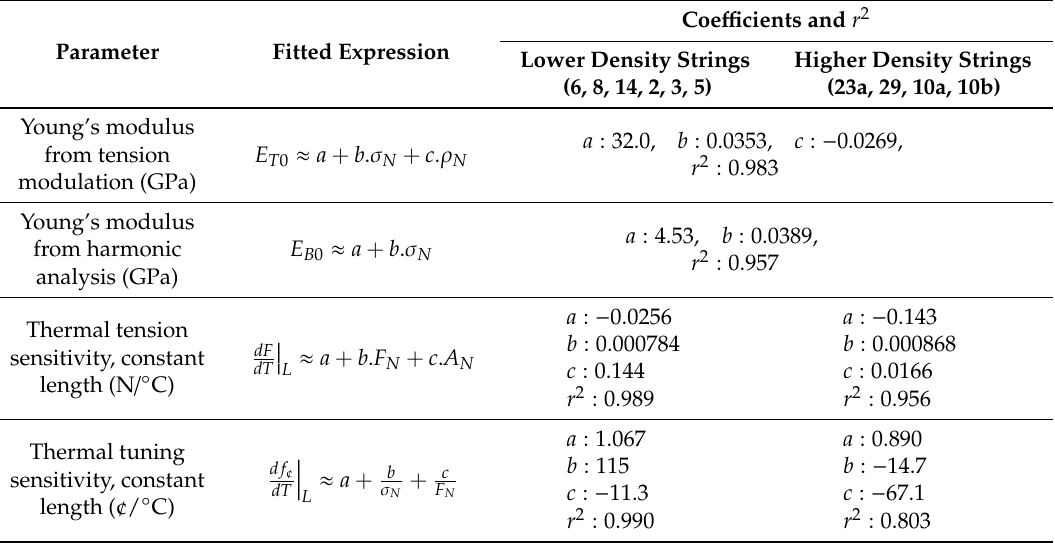
Table A1. Summary of the fitted